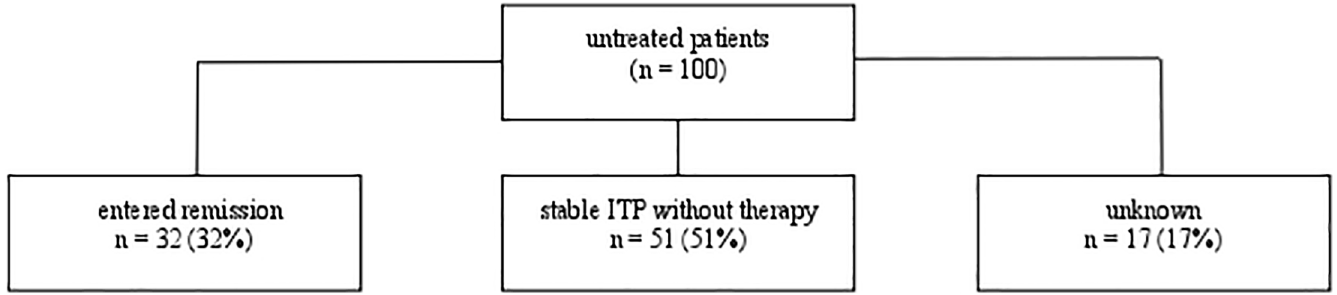
Fig 2. Patients that just required controls due to mild ITP without any therapy during